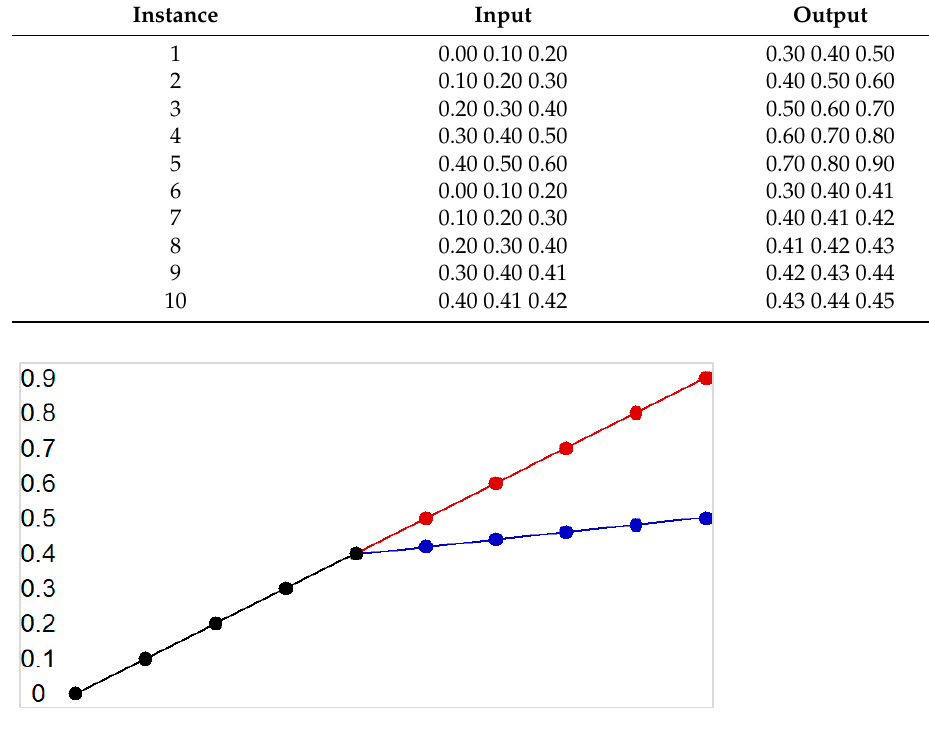
Table 1. The dataset for a simple symmetric bimodal trajectory problem.